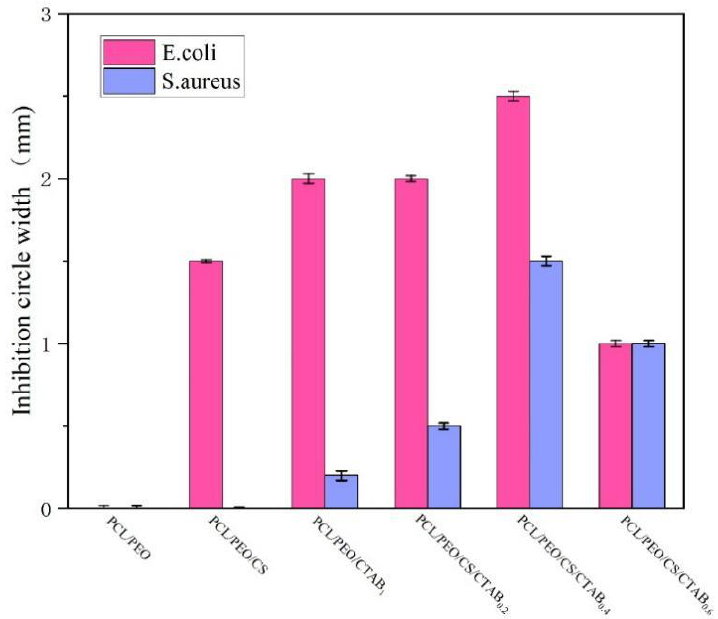
Figure 6. Inhibition circle width of six composite spinning films against S. aureus. and E. coli.